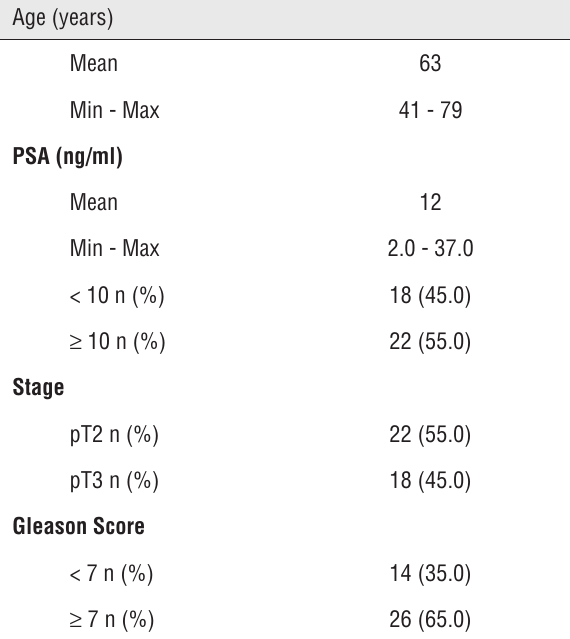
Table 1 - Demographic characteristics of 40 men submitted to radical prostatectomy to treat prostate